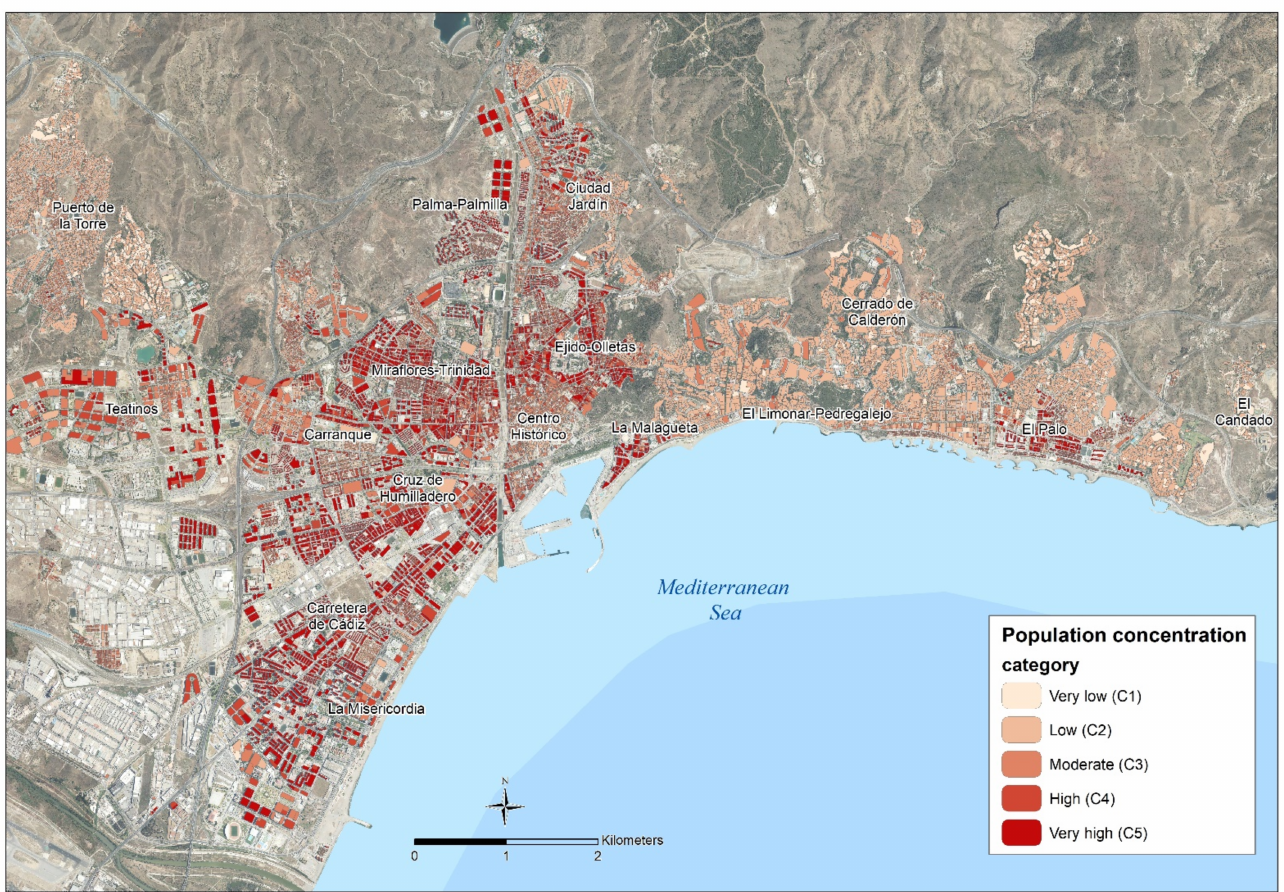
Figure 10. Map of people concentration per building plan. Own